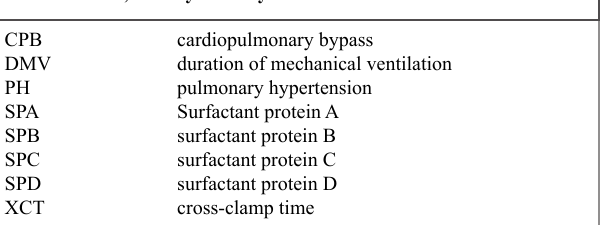
Table 1. Patient diagnose and performed surgery. Diagnose